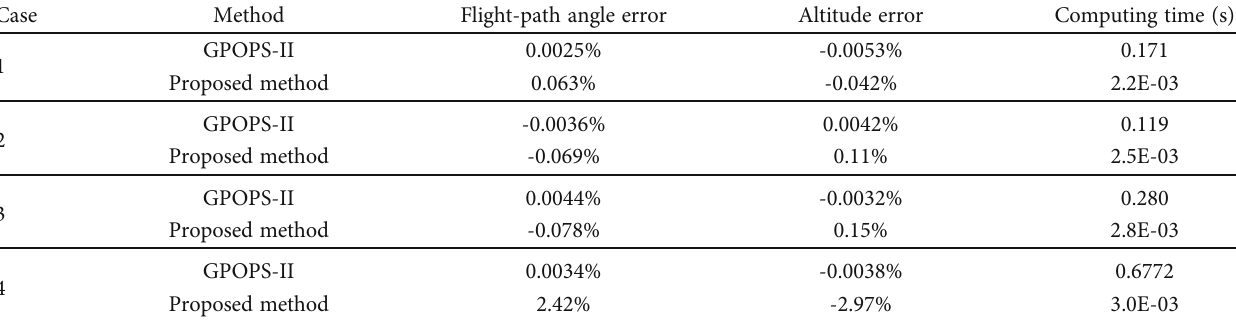
Table 5: Terminal relative errors and computation times for di ff erent cases.